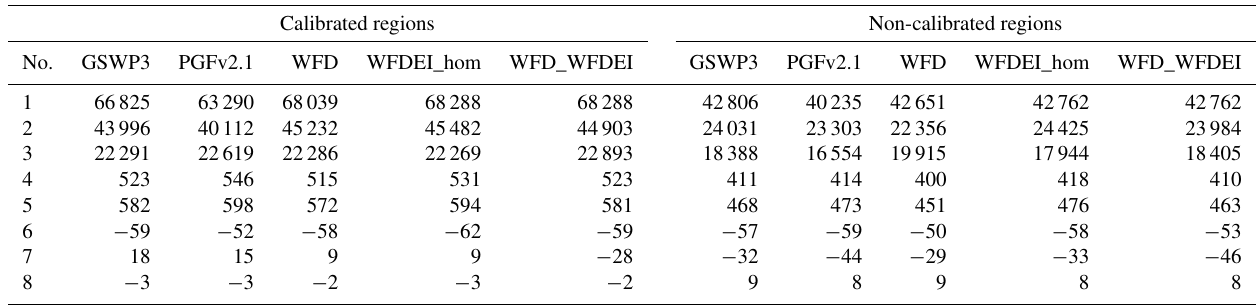
Table 5. Global sums of water balance components for land area (km 3 yr − 1 ) (except Antarctica, Greenland, and inland sinks) (component numbers as in Table 2) for the model variants and the years 1971–2000, divided in calibrated and non-calibrated grid cells. Calibrated regions Non-calibrated